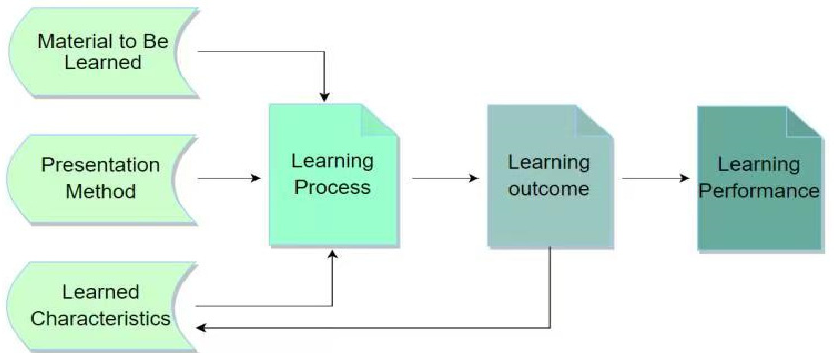
Figure 2. Mayer’s Components of effective Learning (Mayer, 1989; p. 45) (Authors’ illustration).